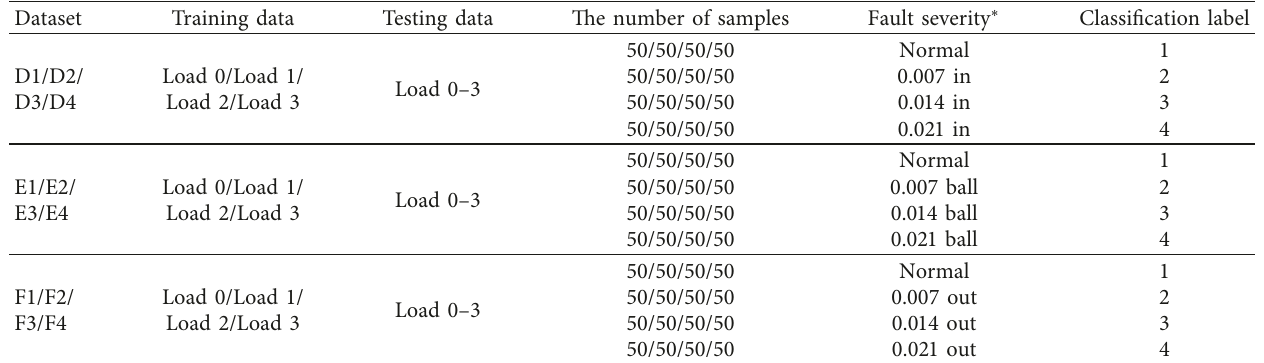
Table 3: Description of bearing datasets for single-fault severity detection.